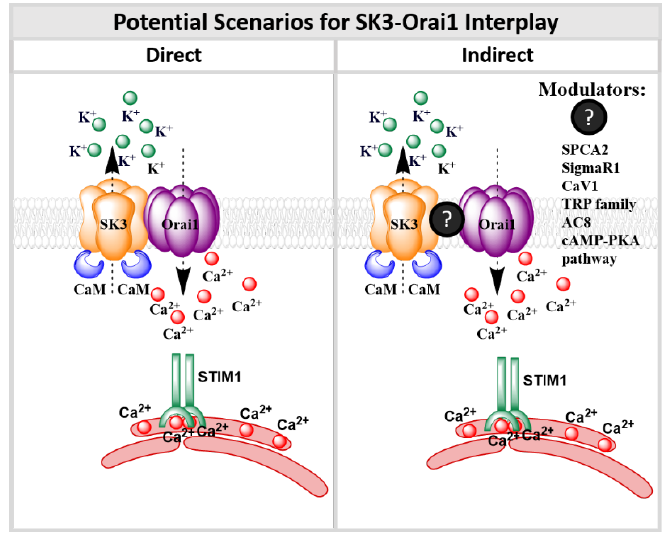
Figure 10. Potential scenarios of SK3-Orai1 interplay. The direct interaction and tight co-regulation between SK3 and Orai1 and potentially STIM1 ( right panel ). The indirect interaction between SK3- and Orai1-mediated through probable modulators such as SPCA2, SigmaR1, Caveolin-1, TRP family or members of cAMP-PKA pathway ( left panel ) in addition to the possible role of STIM1.